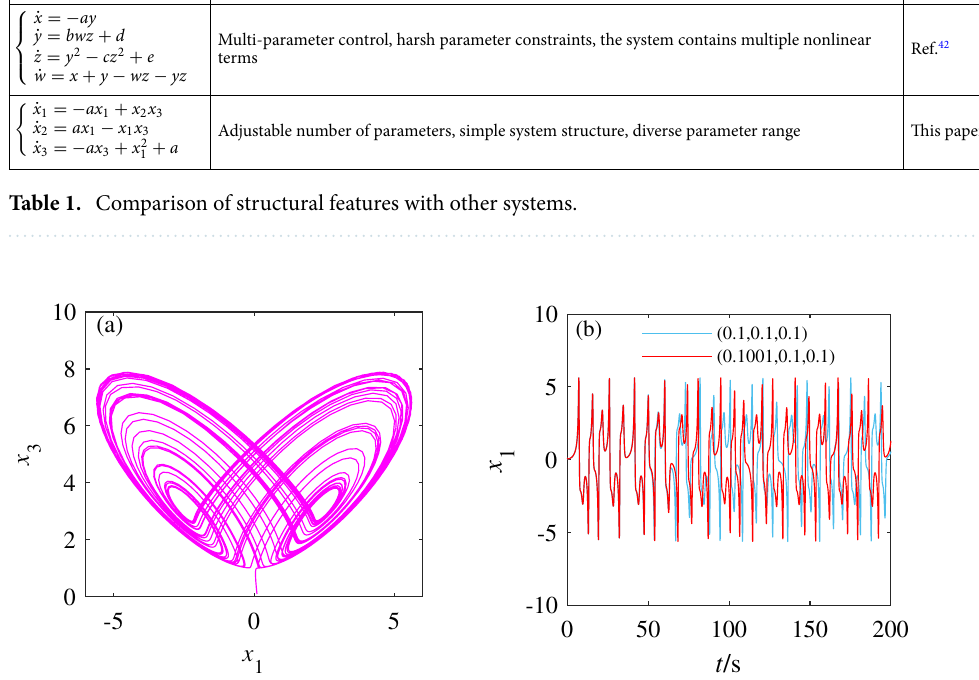
x 3 , the attractor diagram of x 1 3 − =